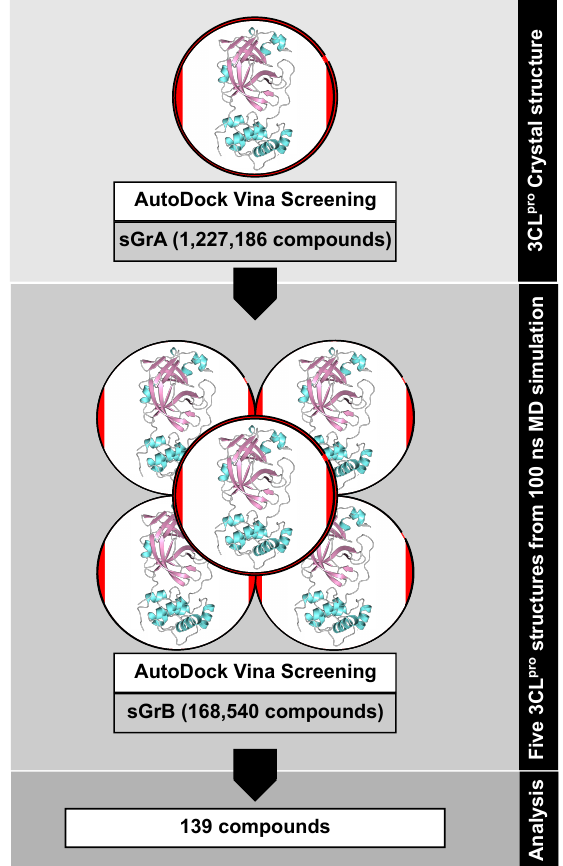
Figure 10. Flowchart of the virtual screening approach adopted in this work.